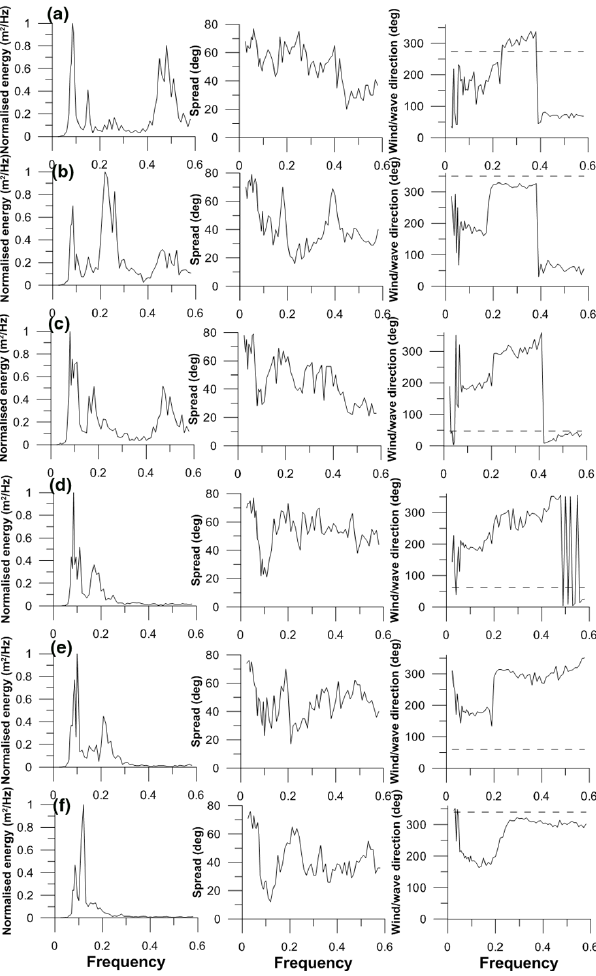
Fig. 7. (a) , (b) , (c) , (d) , (e) and (f) are wave energy spectrum, wave spread and mean wave direction (solid line) and wind direction (dashed line) at (a) 00:00h, (b) 06:00h, (c) 11:00h, (d) 13:00h, (e) 17:00h and (f) 23:00h, respectively, off Dwarka during 22 De- cember